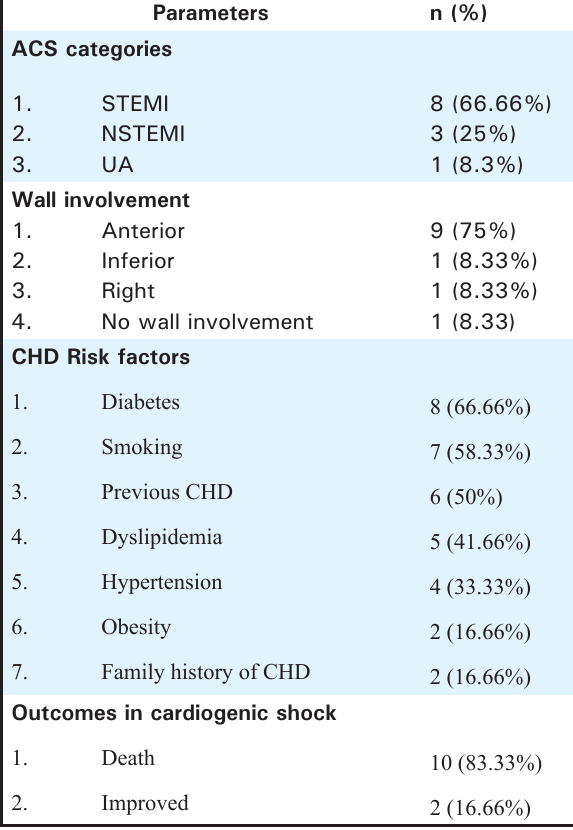
Table 3. Subjects with cardiogenic shock (n =